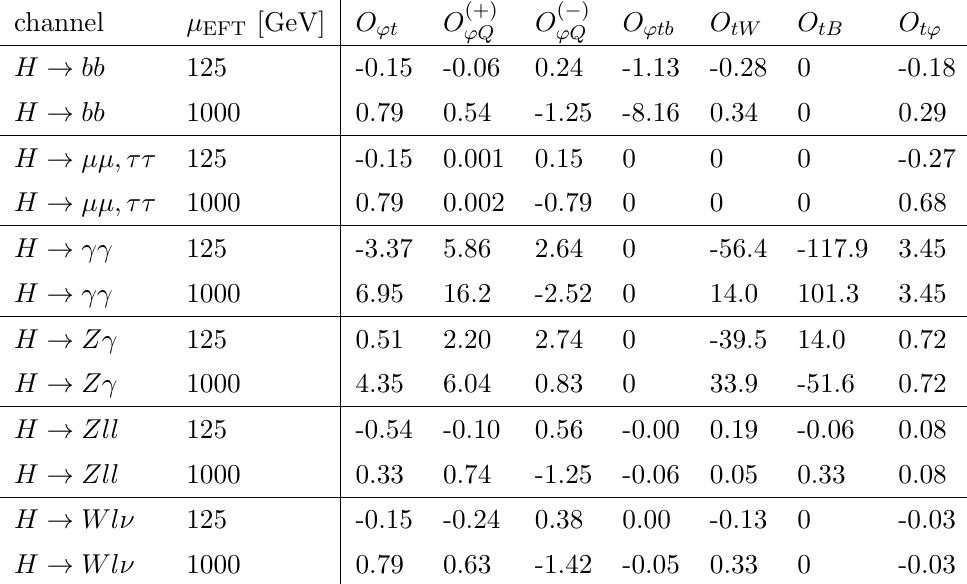
Table 1 . Percentage deviation (cid:22) ij for decay channel i and operator j .